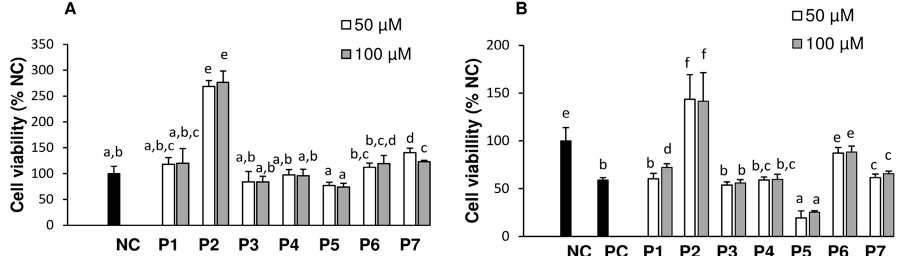
Figure 2. Cytotoxicity and cytoprotective effects of the tested peptides on HepG2 cells: NC (negative control), PC (positive control), FNDRLRQGQLL (P1), GLVYIL (P2), GQTV (P3), control), PC (positive control), FNDRLRQGQLL (P1), GLVYIL (P2), GQTV (P3), GQTVFNDRLRQGQLL GQTVFNDRLRQGQLL (P4), YHNAP (P5), YHNAPGLVYIL (P6), and DVNNNANQLEPR (P7). For (P4), YHNAP (P5), YHNAPGLVYIL (P6), and DVNNNANQLEPR (P7). For cytotoxicity ( A ) Cells cytotoxicity ( A ) Cells were treated with peptides for 24 h and for cytoprotection ( B ) cells were were treated with peptides for 24 h and for cytoprotection ( B ) cells were pretreated with peptides for pretreated with peptides for 24 h followed by 24 h incubation with 20 mM 2,2 ′ -azobis(2- methylpropionamidine) dihydrochloride (AAPH). Negative control (NC) cells were not treated with 24 h followed by 24 h incubation with 20 mM 2,2 (cid:48) -azobis(2-methylpropionamidine) dihydrochloride peptide or APPH while positive control (PC) cells were treated with AAPH only. Data are means ± (AAPH). Negative control (NC) cells were not treated with peptide or APPH while positive control SEM. Different letters indicate significant differences ( p < 0.05) in a post-hoc Tukey’s Honest (PC) cells were treated with AAPH only. Data are means ± SEM. Different letters indicate significant Significant Differences test. differences ( p < 0.05) in a post-hoc Tukey’s Honest Significant Differences